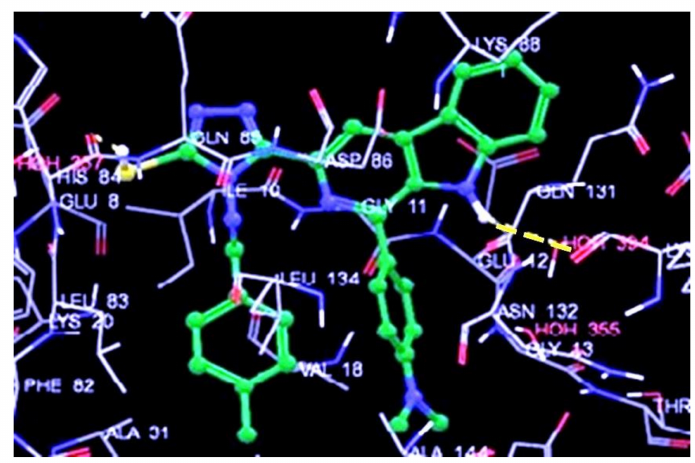
Figure 2. Docking conformation in the active site of CDK2 of most active compound ( 9 ) in the context of hydrogen bonding is displayed as dotted yellow lines.